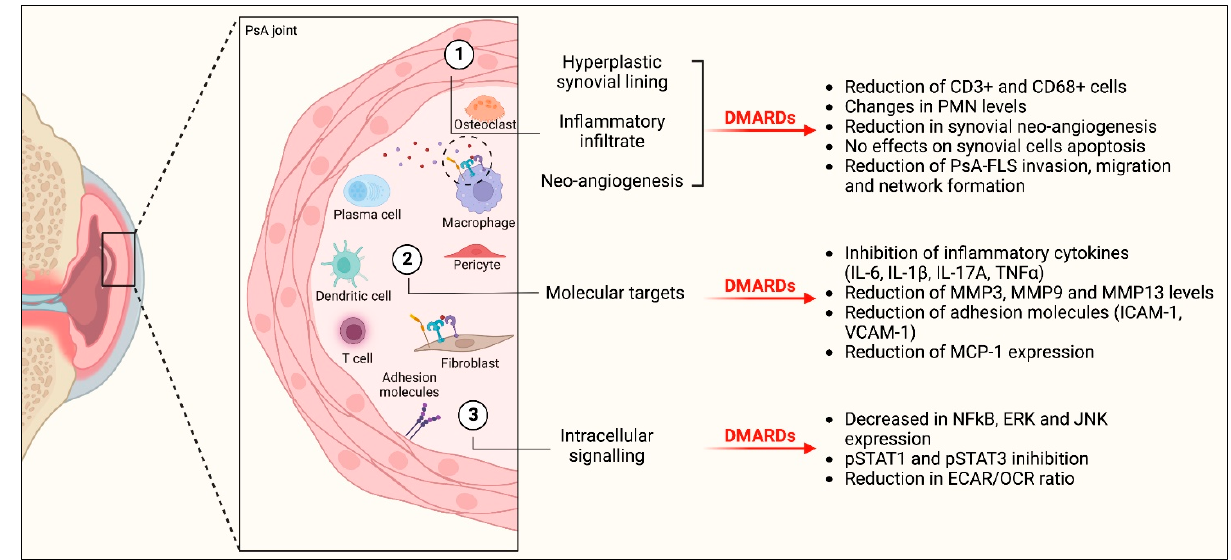
Figure 4. Pictorial view of the main synovial effects of approved b/tsDMARDs retrieved in the literature. Abbreviations: PMN: polymorphonuclear cells, PsA: psoriatic arthritis, FLS: fibroblast-like synoviocytes, IL: interleukin; TNF α : tumor necrosis factor alfa; ICAM-1: intercellular adhesion molecule 1, VCAM-1: vascular cell adhesion protein 1, MMP: matrix metalloproteinases, MCP-1: monocyte chemoattractant protein-1, NFKB: nuclear factor kappaB, ERK: extracellular signal-regulated kinases, c-Jun N-terminal kinases, STAT: signal transducer and activator of transcription, ECAR/OCR: extracellular acidification rate/oxygen consumption rate ratio. This image was created with © BioRender 2021.